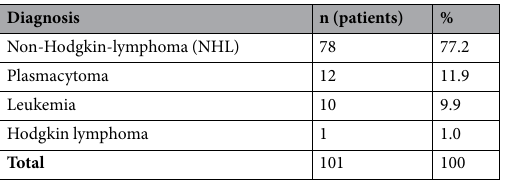
Table 1. Identified intramammary hematological malignancies (IHM).